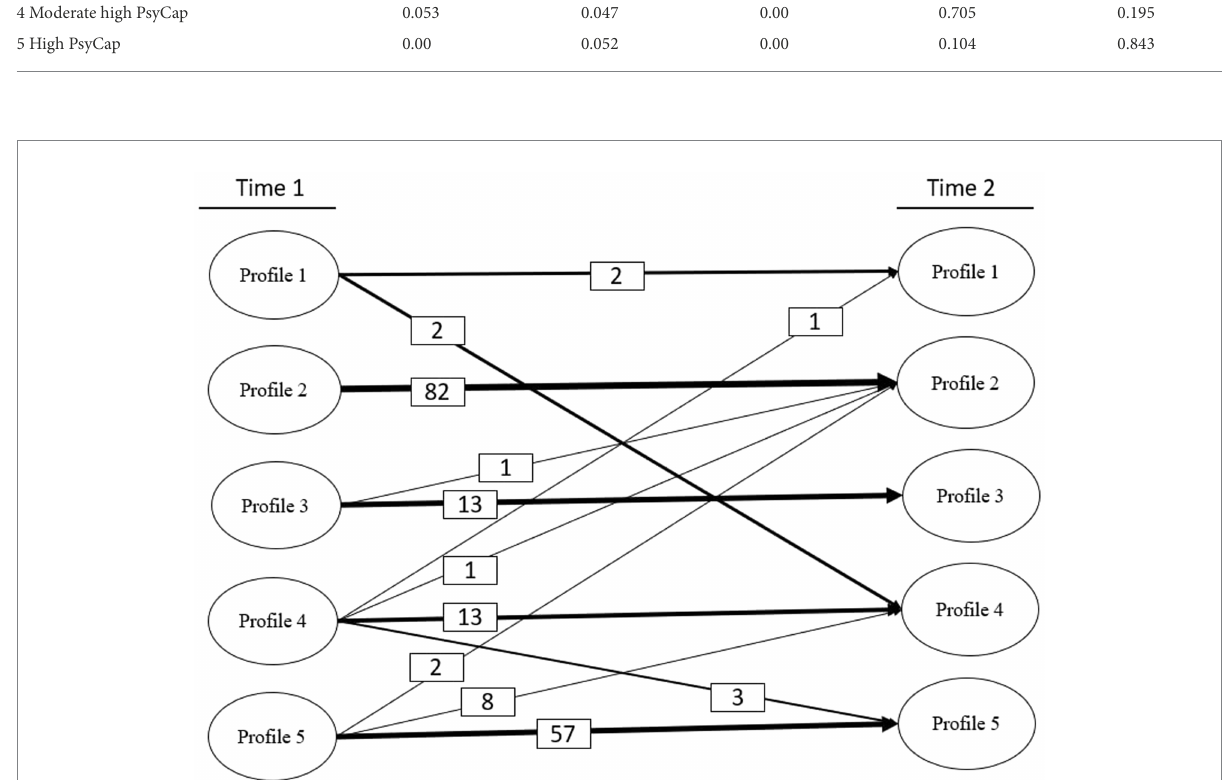
FIGURE 3 Transition paths and prevalence. Thicker lines indicate higher transition prevalence. Values (i.e., numbers in the small boxes) indicate the number of people transitioning between profiles from T1 to